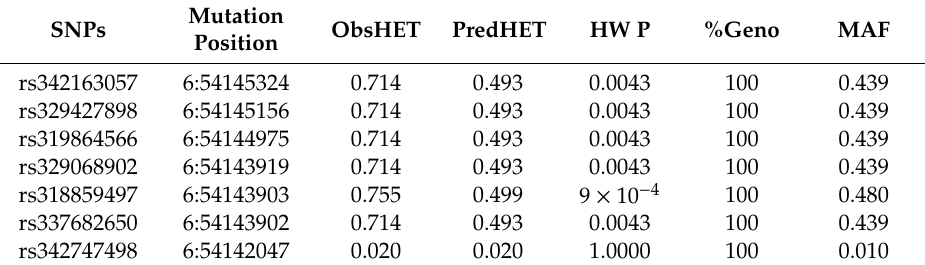
Figure 3. Luciferase assays for porcine HSD17B14 promoter activity analyses. The resulting firefly luciferase activity was normalized to Renilla luciferase activity and the relative values are presented as fold induction over the activity of the pGL3-basic vector. The basic activity value of positive control PGL3-basic was set as 1. PGL3-basic as a negative control and PGL3-control as a positive control. The relative luciferase activity values represent the mean ± SEM of three independent experiments. ( a ) Four luciferase reporter plasmids expressing successive truncations of the HSD17B14 promoter sequence were constructed and transfected into 293T cells. ( b ) Luciferase reporter gene assays of porcine HSD17B14 alleles containing rs342163057 ( − 850G > C). Two genotype luciferase reporter vectors of the HSD17B14 − 949 to − 701 bp sequence were constructed and transfected into 293T cells. ( c ) Luciferase reporter gene assays of porcine HSD17B14 alleles containing rs329427898 ( − 683A > G) and rs319864566 ( − 502T > C). Four genotype luciferase reporter vectors of the HSD17B14 − 720 to − 394 bp sequence were constructed and transfected into 293T cells. The relative luciferase activity values represent the mean ±SEM of three independent experiments. Statistical differences in luciferase activity were assessed using the one-way ANOVA analysis, * p < 0.05, ** p < 0.01, *** p < 0.001. Different letters (a, b and c) indicate that the difference is significant ( p < 0.05). 3.5. Promoter Activity Analyses of Porcine HSD17B14 Gene In the seven SNPs of the HSD17B14 gene, rs342163057 ( − 850G > C) and rs329427898 ( − 683A > G) are located at downstream of the promoter region and rs319864566 ( − 502T > C) is located at the core promoter region. Promoter activity of different genotypes of rs342163057 ( − 850G > C), rs329427898 ( − 683A > G), and rs319864566 ( − 502T > C) in the porcine HSD17B14 gene were analyzed using a dual- luciferase reporter assay system. As shown in Figure 3b, the luciferase activity was greater in plasmids of genotype GG than that of plasmids of genotype CC of rs342163057 ( p < 0.05). In Figure 3c, the luciferase activities of plasmids with combined genotype GGTT, AATT, GGCC, or AACC of rs329427898 ( − 683A > G) and rs319864566 ( − 502T > C) were greater than those of the negative control pGL3-basic group ( p < 0.01) but less than those of the pGL3-control group ( p < 0.01). Luciferase reporter plasmids with combined genotype AATT had less ( p = 0.0451) luciferase activity than that of